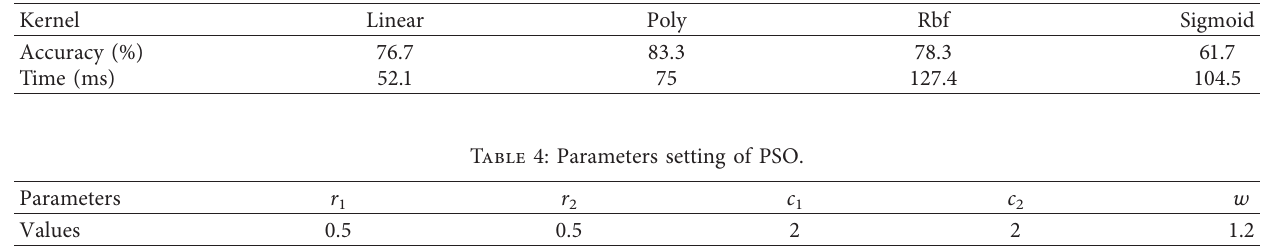
Table 3: Calculation of the four kernel functions.